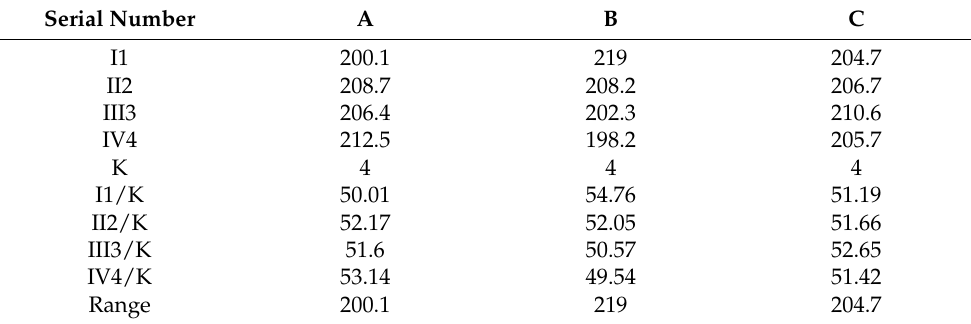
Table 9. Range analysis results of compressive strength.